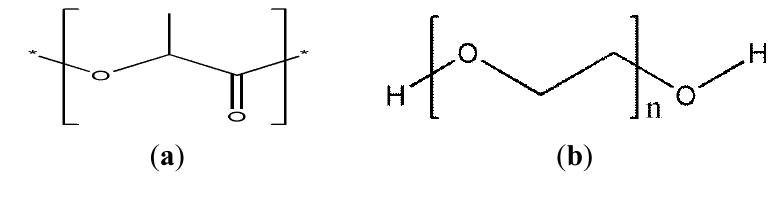
Figure 1. Chemical structures of ( a ) PLA and ( b )